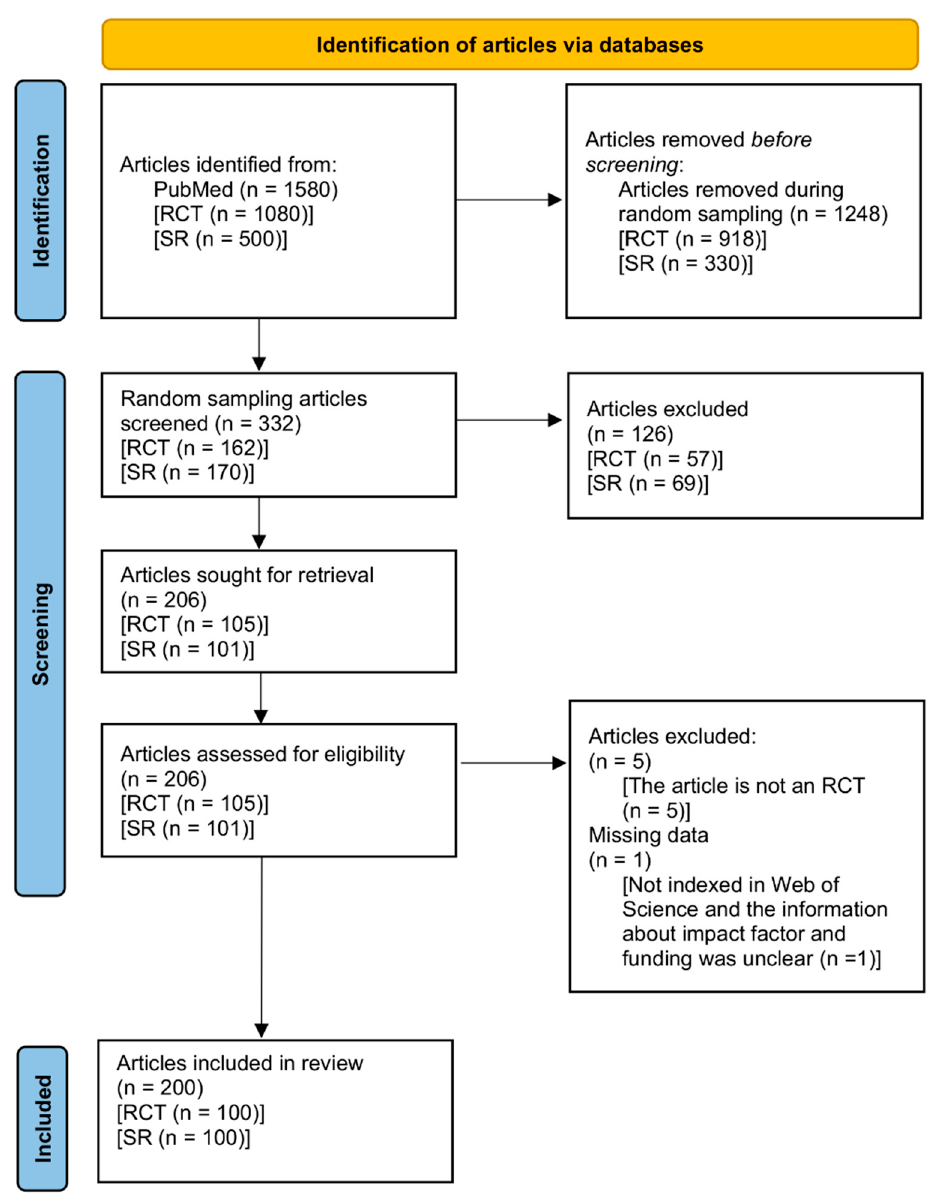
Figure 1. PRISMA 2020 flow diagram. Abbreviations: RCT, randomized controlled trial; SR, system- atic review [28].